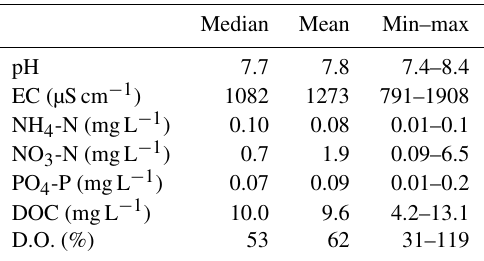
Table 2. Water chemistry at the outlet of the SBM catchment col- lected during June–November 2017 ( n = 8) (Osterman,